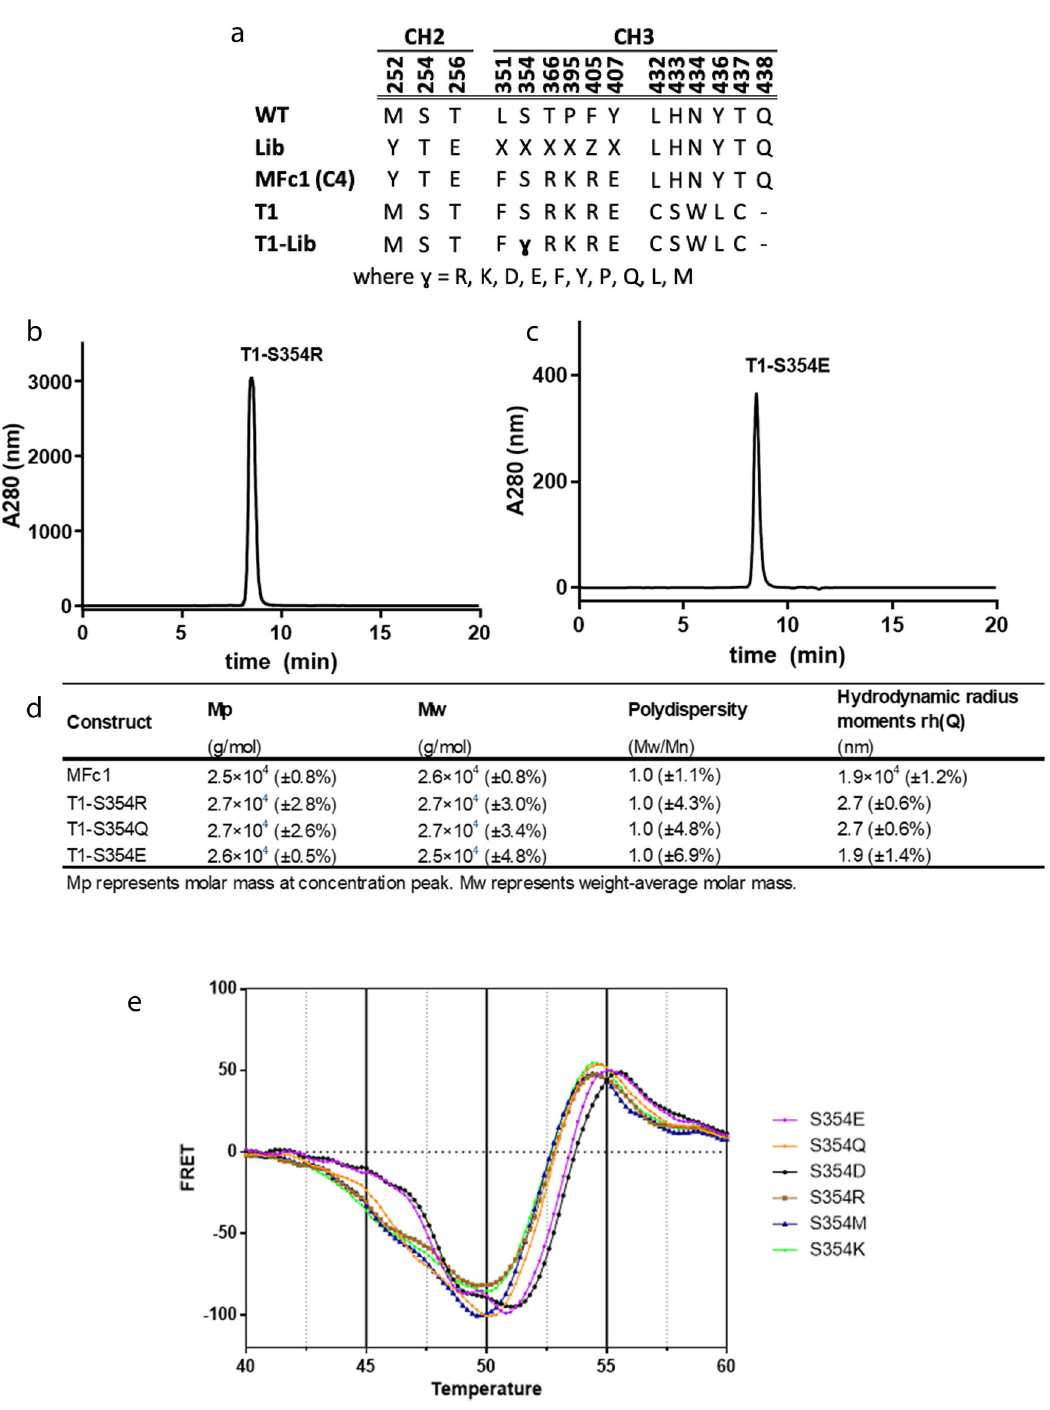
Fig. 2 Rational engineering to enable next-generation MFc designs. a Sequence alignment of CH2 and CH3 domains in wild-type IgG4, T1, and T1-lib, a panel of point-mutation variants targeting residue S354. b – d Representative SEC-MALS analysis results showing the T1 point mutants demonstrating a molecular weight of approximately 26 – 27 kDa with good homogeneity; e DSF comparisons among the T1 re fi nement mutants to identify S354E and S354D with moderately higher thermal